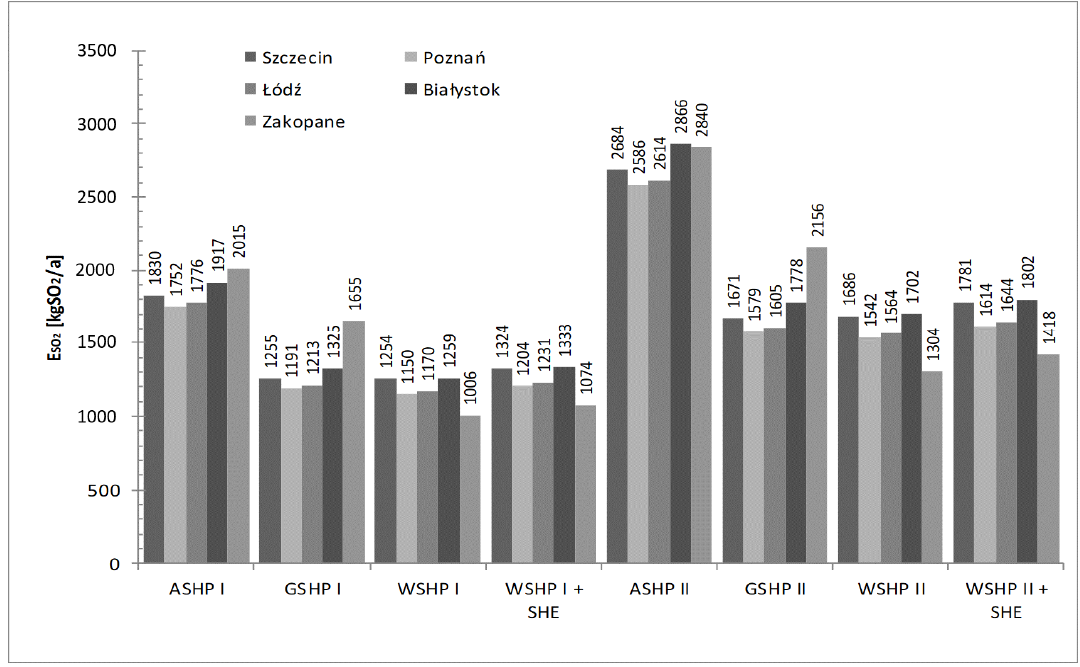
Figure 7. Indirect emissions of sulphur dioxide values for specific locations in the variants I and II.